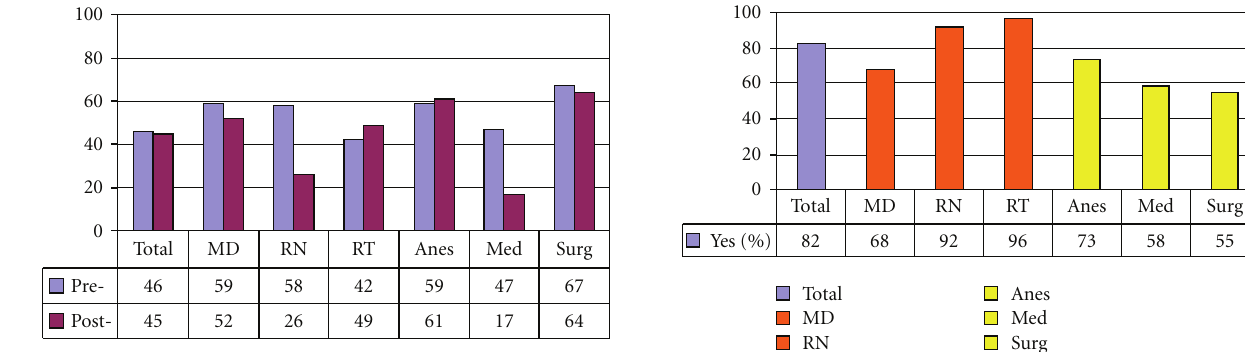
Figure 7: Do not continue ventilating an obstructed or displaced tracheotomy tube (% Correct).